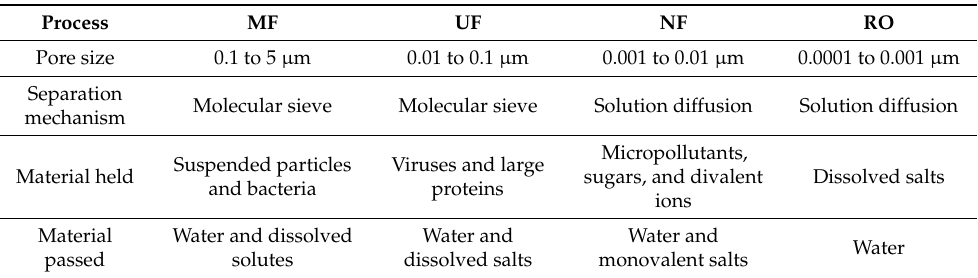
Figure 4. Filtration spectrum of commercial membranes based on the pore diameter and material retained [139]. Table 6. Membrane specifications based on the pore size and their separation process including RO (Adapted from [63,140,141]).